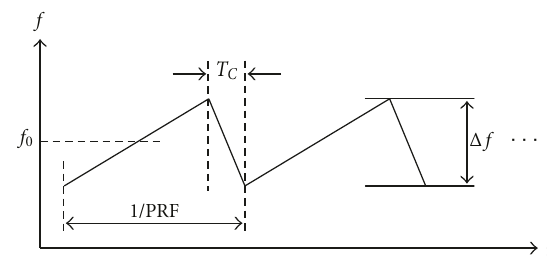
Figure 2: Waveform for an LFMCW